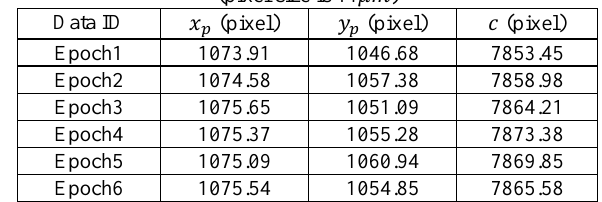
Table 2. Sample IOPs of camera model 1